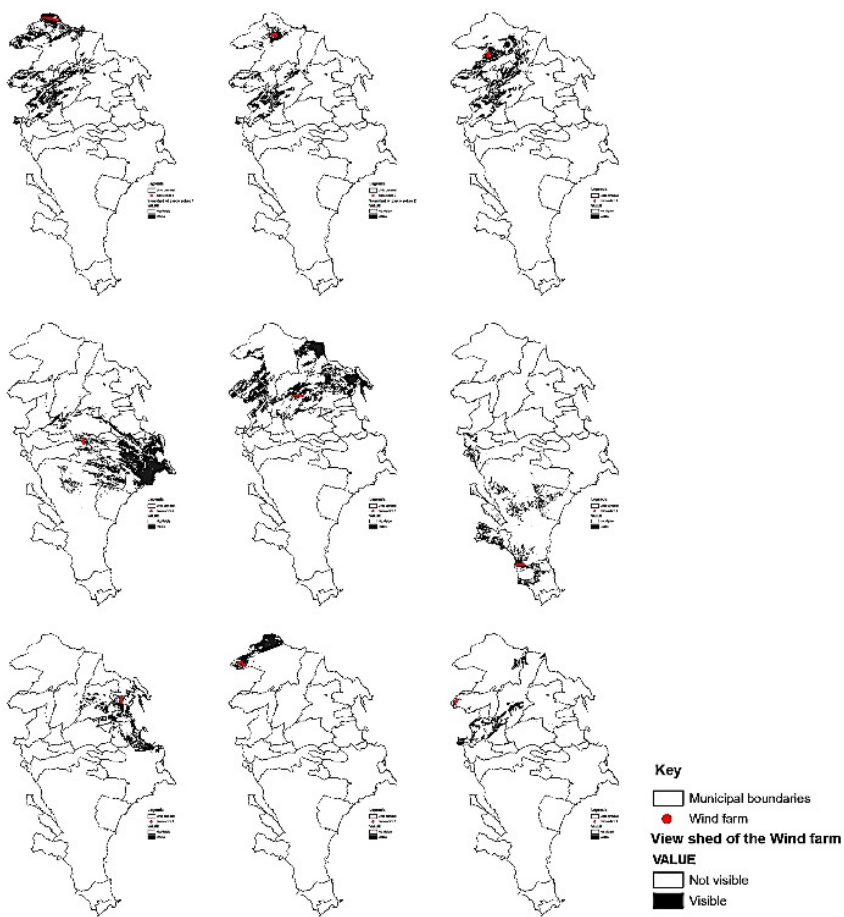
Figure 10. Partial intervisibility of the wind farms considered in the province of Siracusa (our GIS calculation).